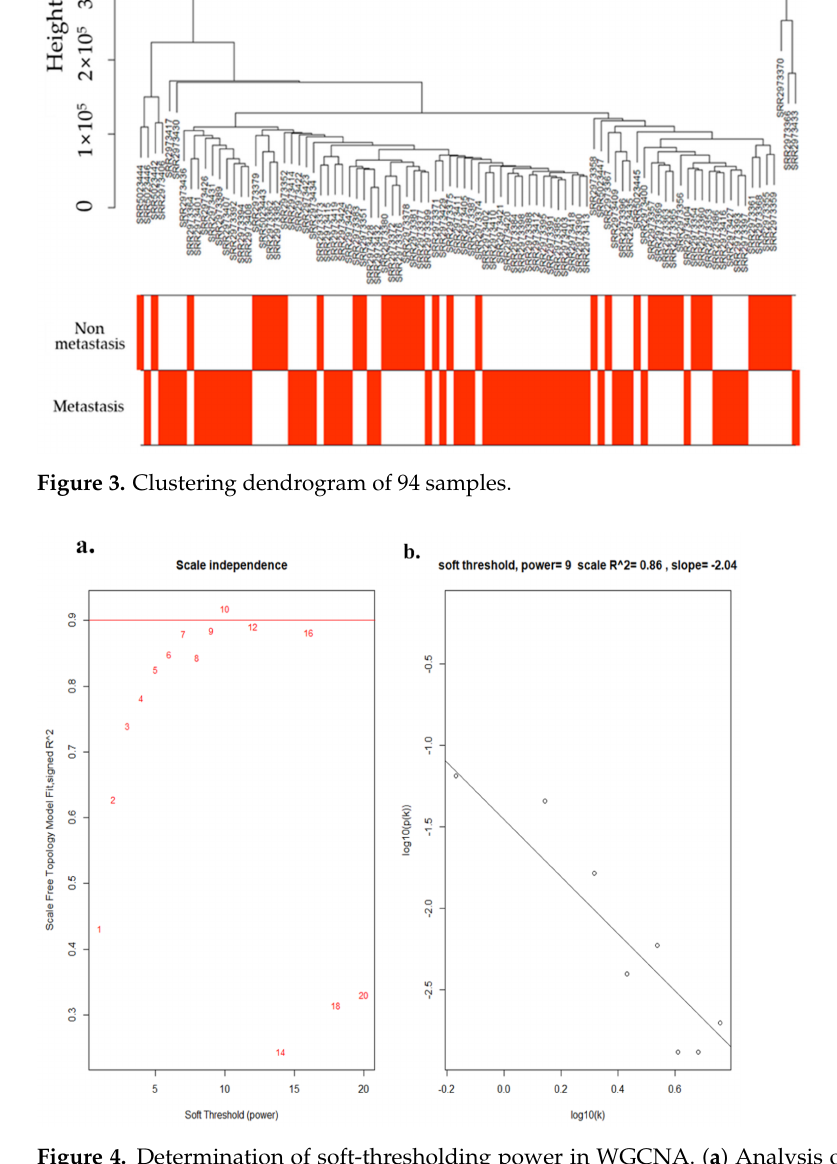
Figure 4. Determination of soft-thresholding power in WGCNA. ( a ) Analysis of the scale-free fit index for various soft-thresholding powers ( β ). ( b ) Analysis of the mean connectivity for various soft-thresholding powers. ( b ) Evaluating the scale free topology when β =